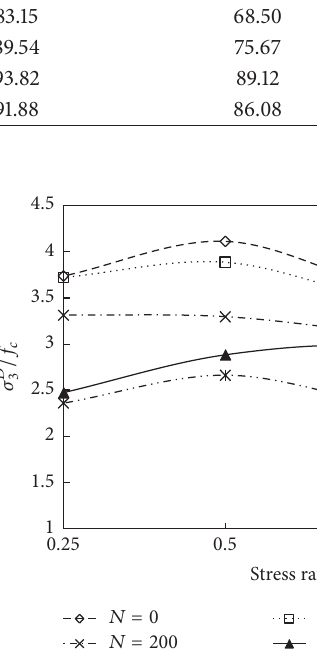
Biaxial equal compression